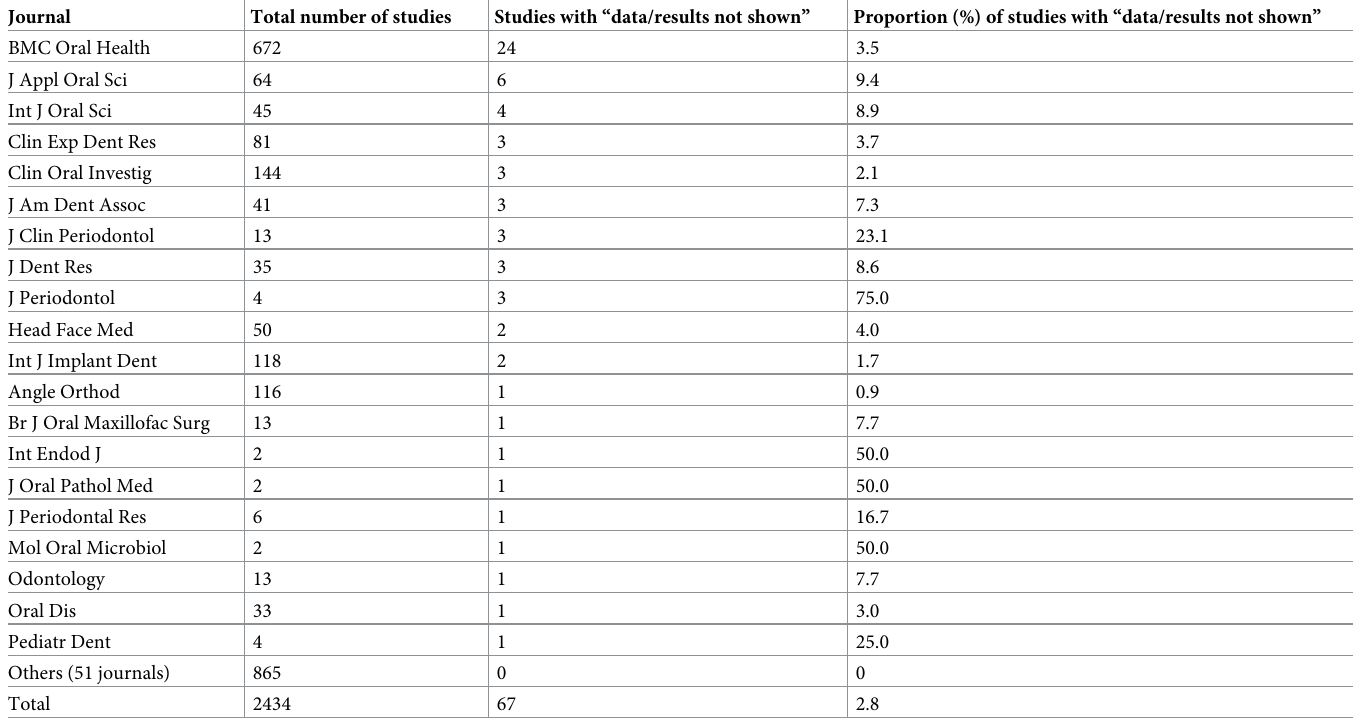
Table 2. The number of available open access articles from Europe PubMed Central and the number of articles with “data/results not shown” phrases in each journal. Journal Total number of studies Studies with “data/results not shown” Proportion (%) of studies with “data/results not